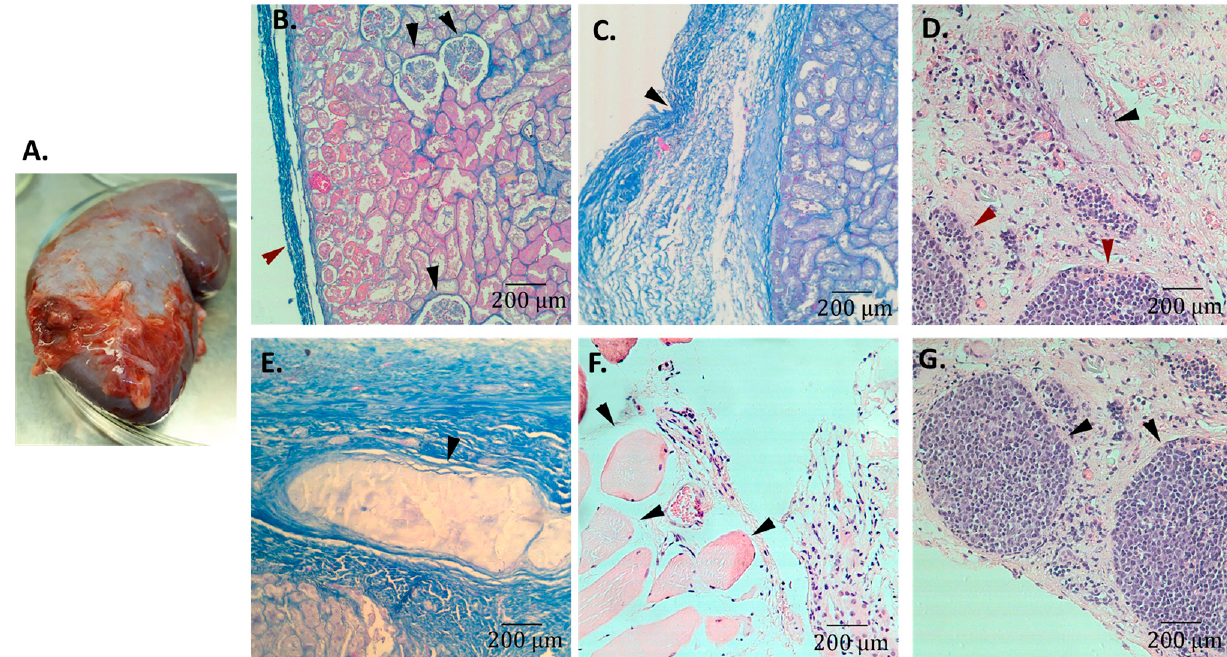
Figure 2. Photos of ectopic foci formed under the kidney capsule of mini pigs after BM-MSCs implantation. ( A ) Overview of the implant. The diameter of the Petri dish is 10 cm. The implant is approximately 2 × 3 cm. Bones are palpable inside. (Pig#103). ( B ) Histological sections of implants. As a control, normal kidney with a connective tissue capsule without an implant is represented. Mallory staining. (Pig#107) Red arrow points to the normal renal capsule. Black arrows indicate renal glomeruli. ( C ) The marginal area of the implant with connective tissue and blood vessels. Mallory staining. (Pig#103) Black arrow points to the renal capsule with part of implant. ( D ) Ossicles (black arrows) and ectopic hematopoietic foci (red arrows) containing stromal cells. Hematoxylin–eosin staining. (Pig#106). ( E ) Ossicle. Mallory staining. (Pig#103). ( F ) Area containing muscle cells. Hematoxylin–eosin staining. (Pig#103). ( G ) Ectopic hematopoietic foci. The area adjacent to the one presented in ( D ) is shown. Hematoxylin–eosin staining. (Pig#106). Magnification 10 × . Some small pieces of implant approximately 0.3 × 0.3 cm were placed in a six-well plate in alpha-MEM medium with 10% FBS for further cultivation (Figure